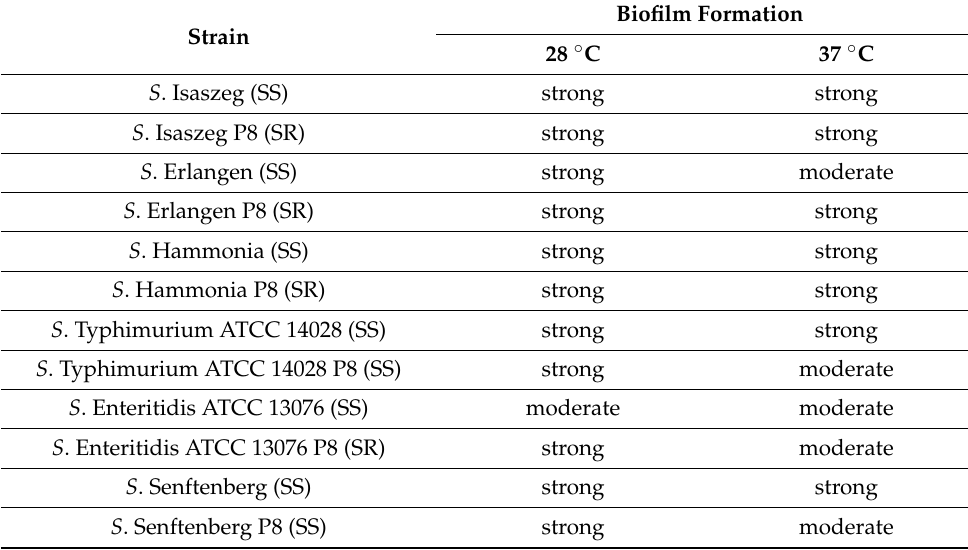
Table 4. Biofilm production by wild-type Salmonella enterica strains and passaged in 50% SPPP determined by microtiter plate assay at 28 ◦ C and 37 ◦ C. Interpretation of the results: OD ≤